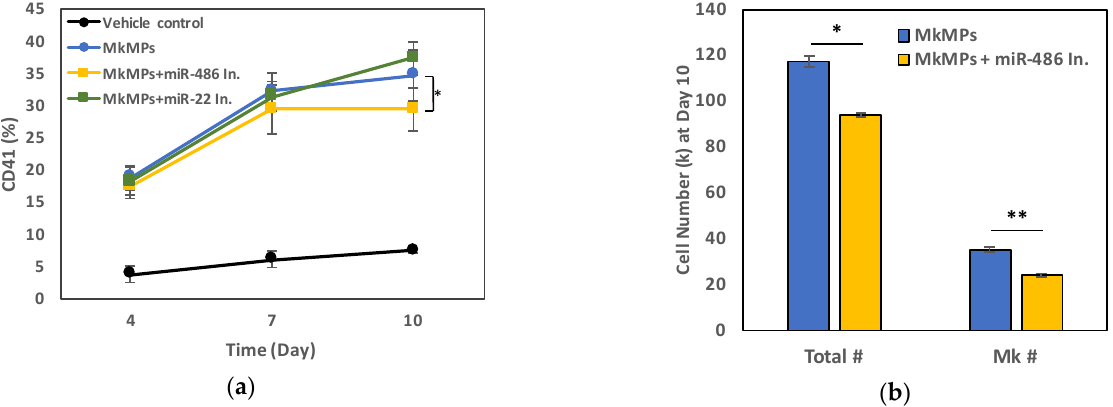
Figure 4. Loading of an miR-486-5p inhibitor into MkMPs reduces the native effect of MkMPs in inducing Mk differentiation of CD34 + HSPCs. ( a ) CD34 + HSPCs were co-cultured with MkMPs, 8 µM-miR-486-5p inhibitor-loaded MkMPs, 8 µM-miR-22-3p inhibitor-loaded MkMPs, or vehicle control. Cells were harvested for flow cytometric analysis on CD41 expression at day 4, 7, and 10. ( b ) MkMPs or 16 µM-miR-486-5p inhibitor-loaded MkMPs were co-cultured with CD34 + HSPCs. Total cell or Mk cell (CD41 + cells) numbers were measured at day 10. * p < 0.05, ** p < 0.01.